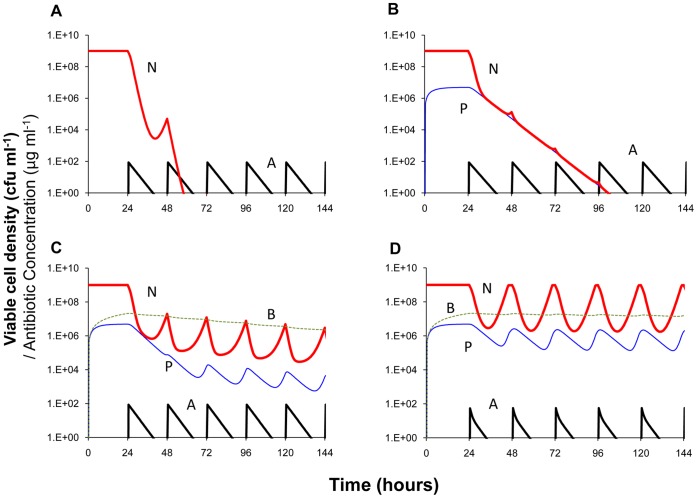
Simulation of antibiotic treatment of bacteria in continuous culture (numerical solutions to the model used in [44]; changes in viable cell density and antibiotic concentration.100× MIC of antibiotic administered every 24 hours starting on the second day, 24 hours. Standard parameters, C = 500, Vmax = 1, Vmin = −1, κ = 1, km = 0.25, e = 5×10−7, Mmin = 1, Mmax = 40, ka = 10−7, f = 0, pd = 0, cr = 0.9, dx = 0.1, dv = 0, dk = 0,. A - No persistence or wall population. B - An antibiotic refractory persister, P, population, VmaxP = 0.001, VminP = −0.001, fNP = fPN = 0.001. C - An antibiotic refractory persister, P, and wall population, B, VmaxB = 0.001, VminB = −0.1, fNB = 0.001, fBN = 0.01, wB = 0.001. D - An antibiotic persister and wall population with density-dependent decay in the effective concentration of the antibiotic, dv = 10−9. The definitions and dimensions of these parameters are presented in the text and Table 1 of [44] where the model is described in detail. Copies of the Berkeley Madonna™ program used for these simulations can be downloaded from www.eclf.net/programs.